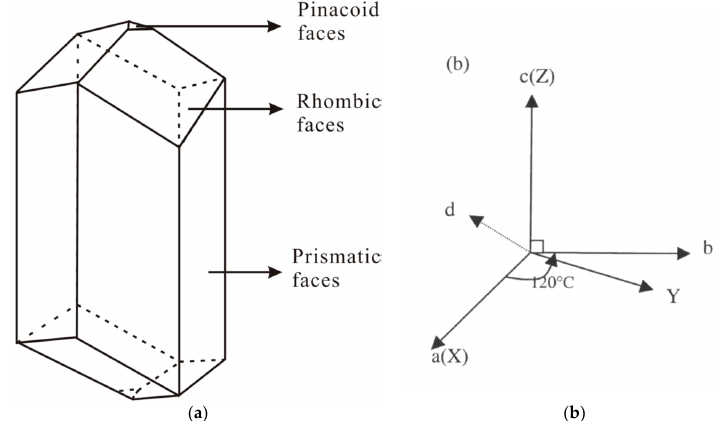
Figure 1. ( a ) The growth habit of Nd:YAB crystals and ( b ) the hexagonal crystal axes for the crystals.